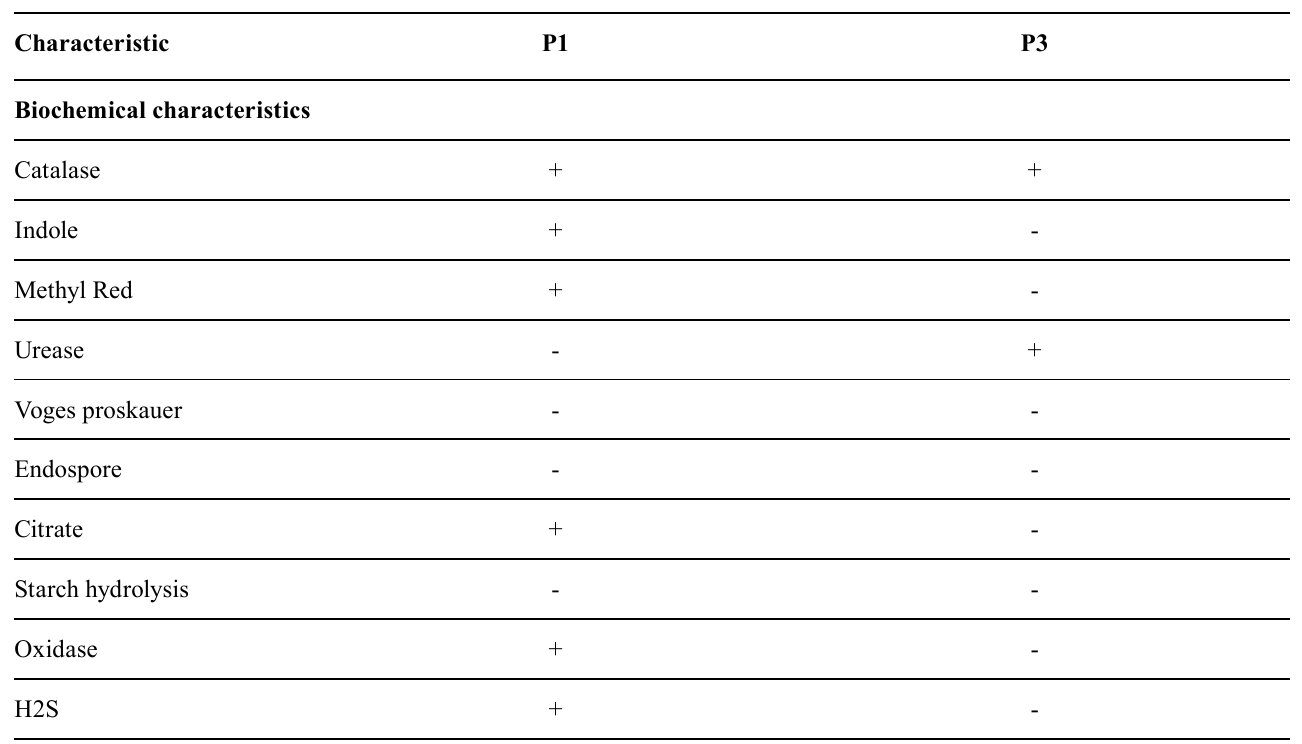
TABLE II – Morphological and Biochemical characterization of isolates Characteristic P1